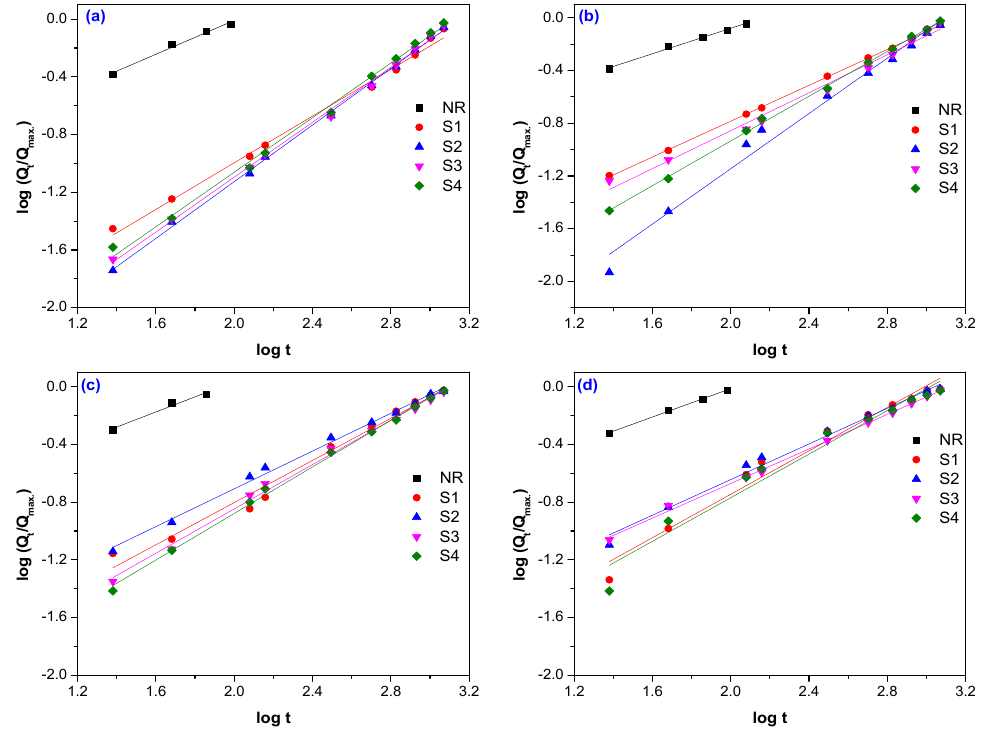
Figure 7. Determination of the diffusion parameters n and k for NR samples reinforced with sawdust and vulcanized by EB irradiation at 75 kGy ( a ), 150 kGy ( b ), 300 kGy ( c ) , and 600 kGy ( d ). Table 5. Values of n and k × 10 2 parameters as a function of irradiation dose.